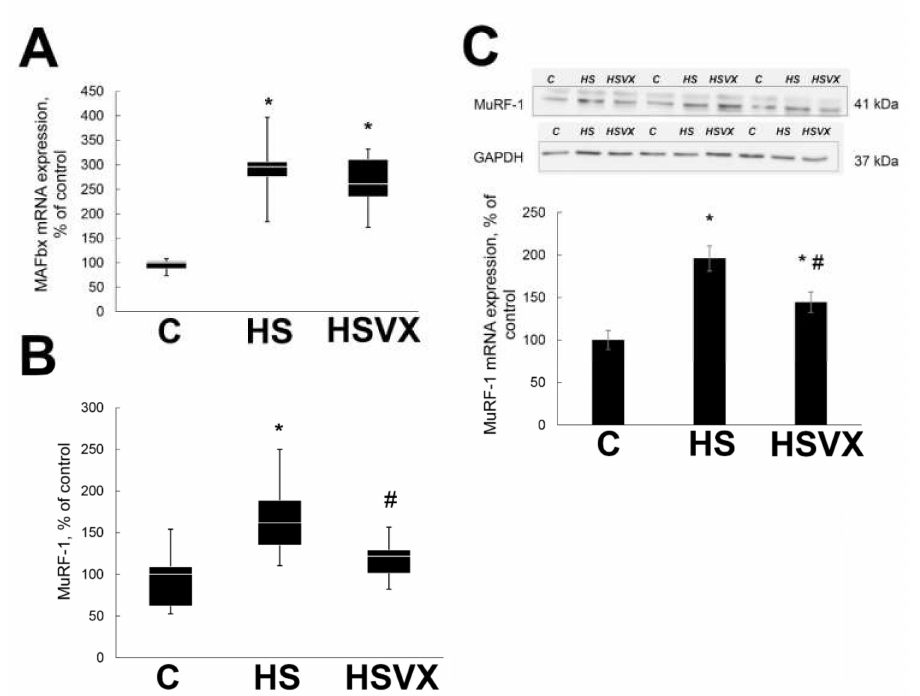
Figure 4. Expression of muscle-specific E3 ubiquitin ligases muscle atrophy F-box (MAFbx) mRNA ( A ) and muscle RING-finger protein-1 (MuRF1) mRNA ( B ) and protein ( C ) in soleus muscles of C, HS, and HSVX rats. ( A , B ) Values are normalized to the level of GAPDH mRNA expression in each sample. ( C ) Values are normalized to the levels of total protein and GAPDH protein content in each sample. n = 8. * indicates a significant di ff erence from the control, p < 0.05; # indicates a significant di ff erence from the HS, p <